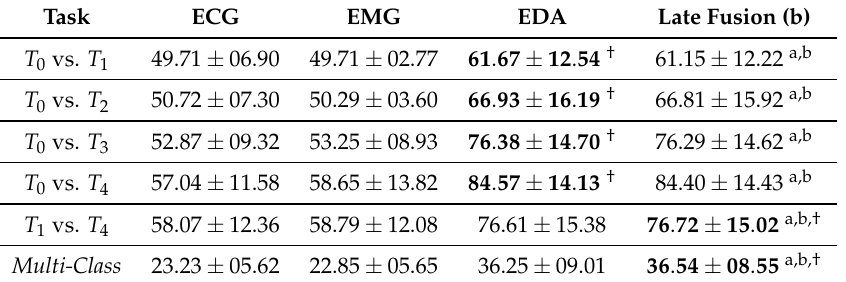
Table 4. CNN Classification performance on the BVDB (Part A) in a LOSO cross-validation setting (the multi-class classification task corresponds to the five-class classification task T 0 vs. T 1 vs. T 2 vs. T 3 vs. T 4 ).